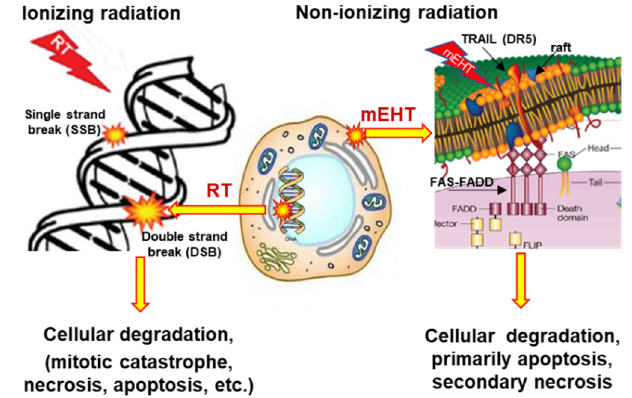
Figure 6. The conceptual similarity of RT and mEHT. Both therapies target molecular bonds, so the